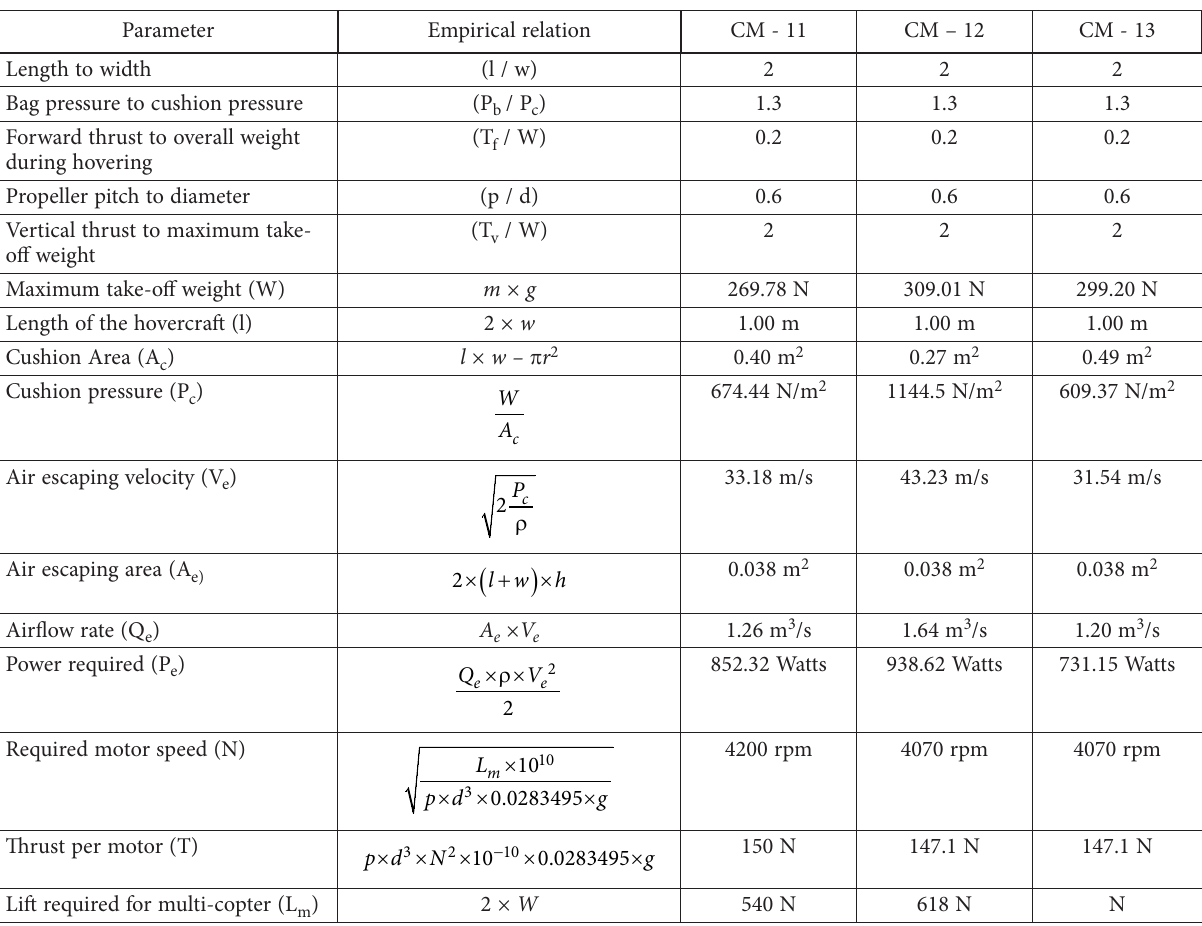
Table A6. Design parameters of